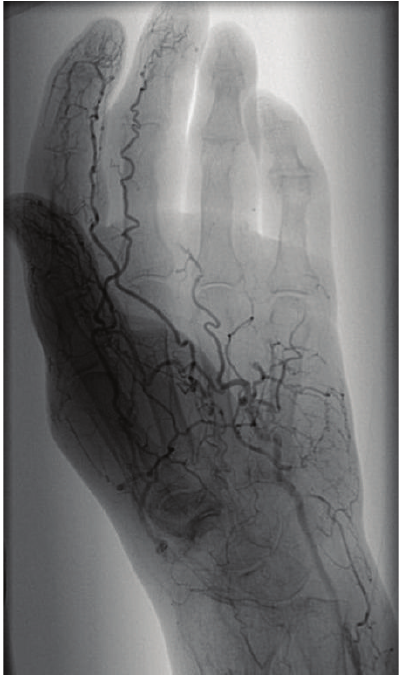
Figure 2: Digital angiography showing complete blockage of per- fusion to the 4th and 5th digits.